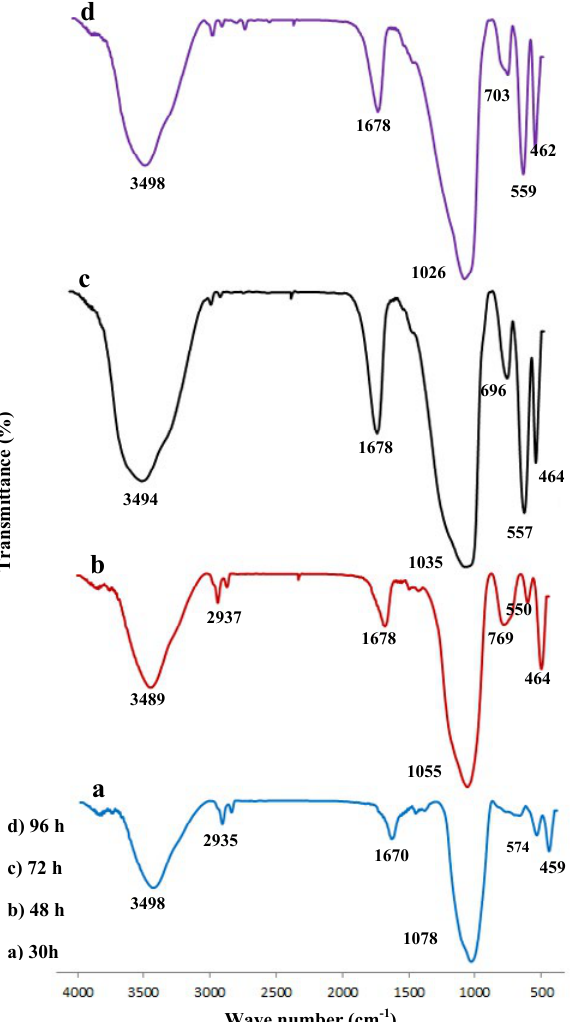
Fig. 8: FT-IR spectra of samples synthesized at 98 o C and crystallization times of 30, 48, 72 and 96 h.